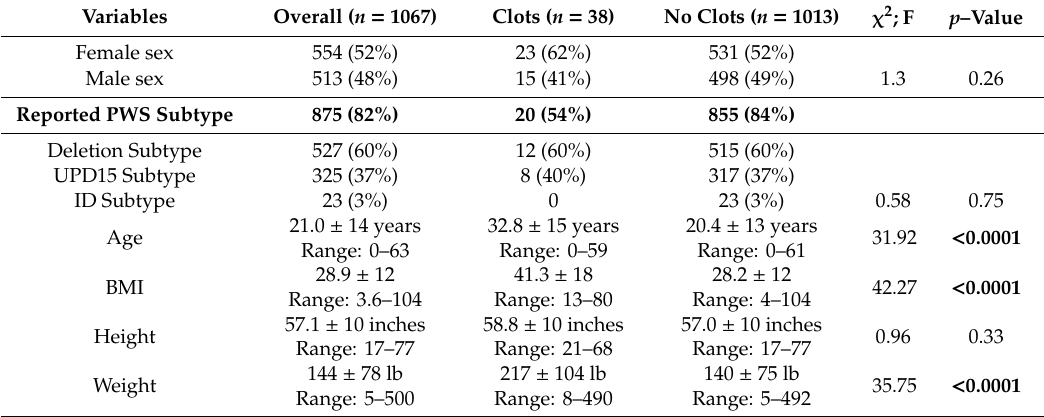
Table 1. Sample characteristics for n = 1067 total on Prader–Willi syndrome